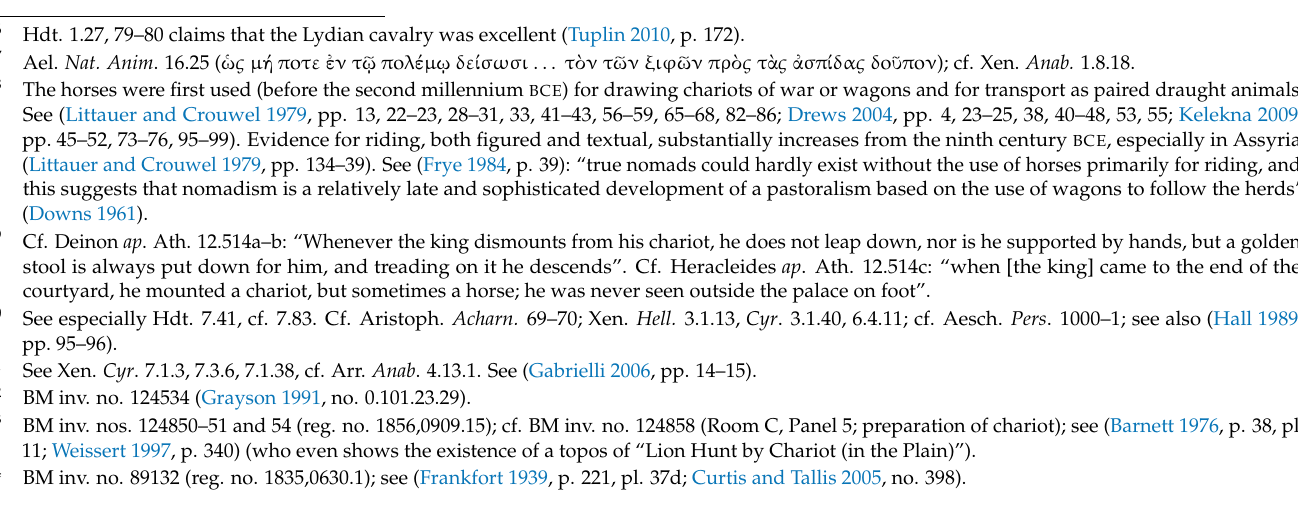
Figure 2. King Ashurnasirpal II hunting lions (BM inv. no. 124534; reg. no. 1847,0623.11); relief scene, gypsum; NW Palace, Nimrud (mod. Iraq); Neo-Assyrian, ca. 865–860 BCE [image courtesy of the Trustees of the British Museum, London].